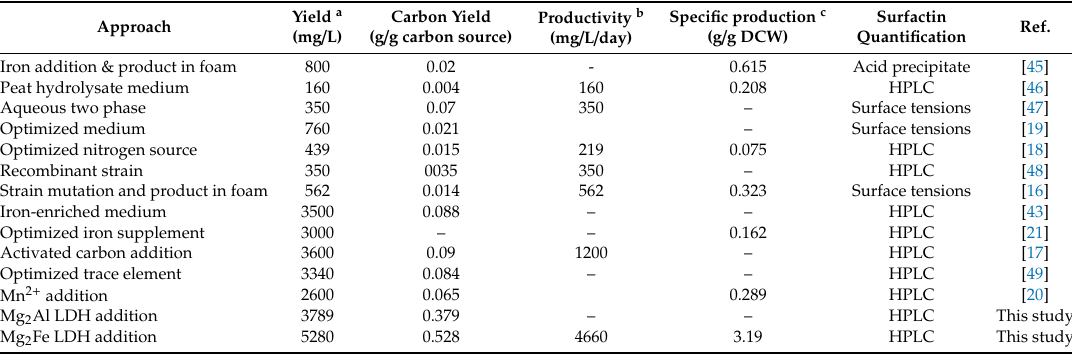
Table 1. Various approaches used for surfactin production.